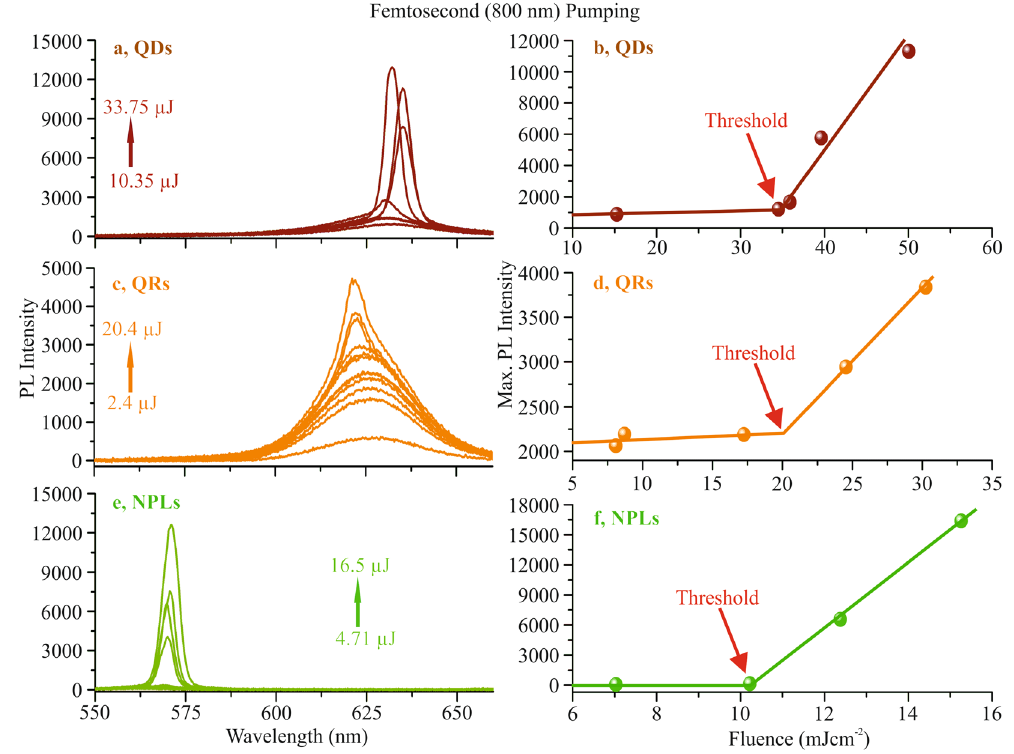
Figure 3. Femtosecond fundamental pumping emission of different nanoparticles. The energy variation with minimum and maximum in each nanoparticles coated film is shown by arrow in each graph (a for QDs, c for QRs and e for NPLs). The ( b , d , f ) represent the threshold values at the maximum peak intensity wavelength for each particle. The threshold values of QDs ( b ), QRs ( d ) and NPLs ( f ) are at pump fluences of ≈ 35 mJ cm − 2 , ≈ 20 mJ cm − 2 and ≈ 10.5 mJ cm − 2 ,